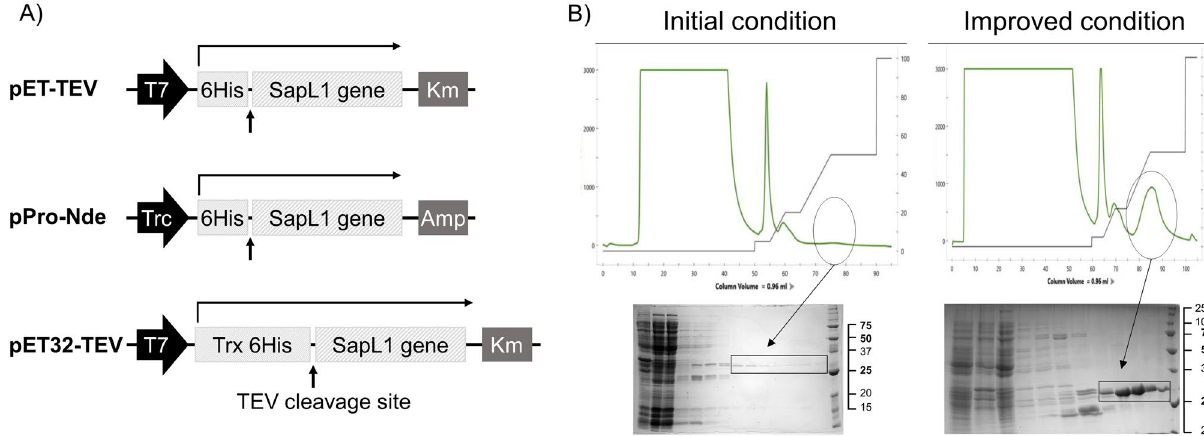
Figure 1. SapL1 production. ( A ) Schematic representation of the genetic constructs used for the expression of SapL1. ( B ) Representative chromatograms of SapL1 purification before and after the process with their respective profile on 15% SDS–polyacrylamide gels (insoluble fraction, soluble fraction, flow through, washing and elution and molecular weight marker, from left to right respectively). The fractions containing SapL1 are